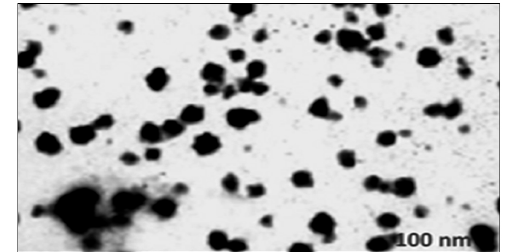
Fig. 6. Well diffusion assay of the chitosan nanoparticles conjugated with antibiotics towards S.aureus (P1) and E.coli (P2).